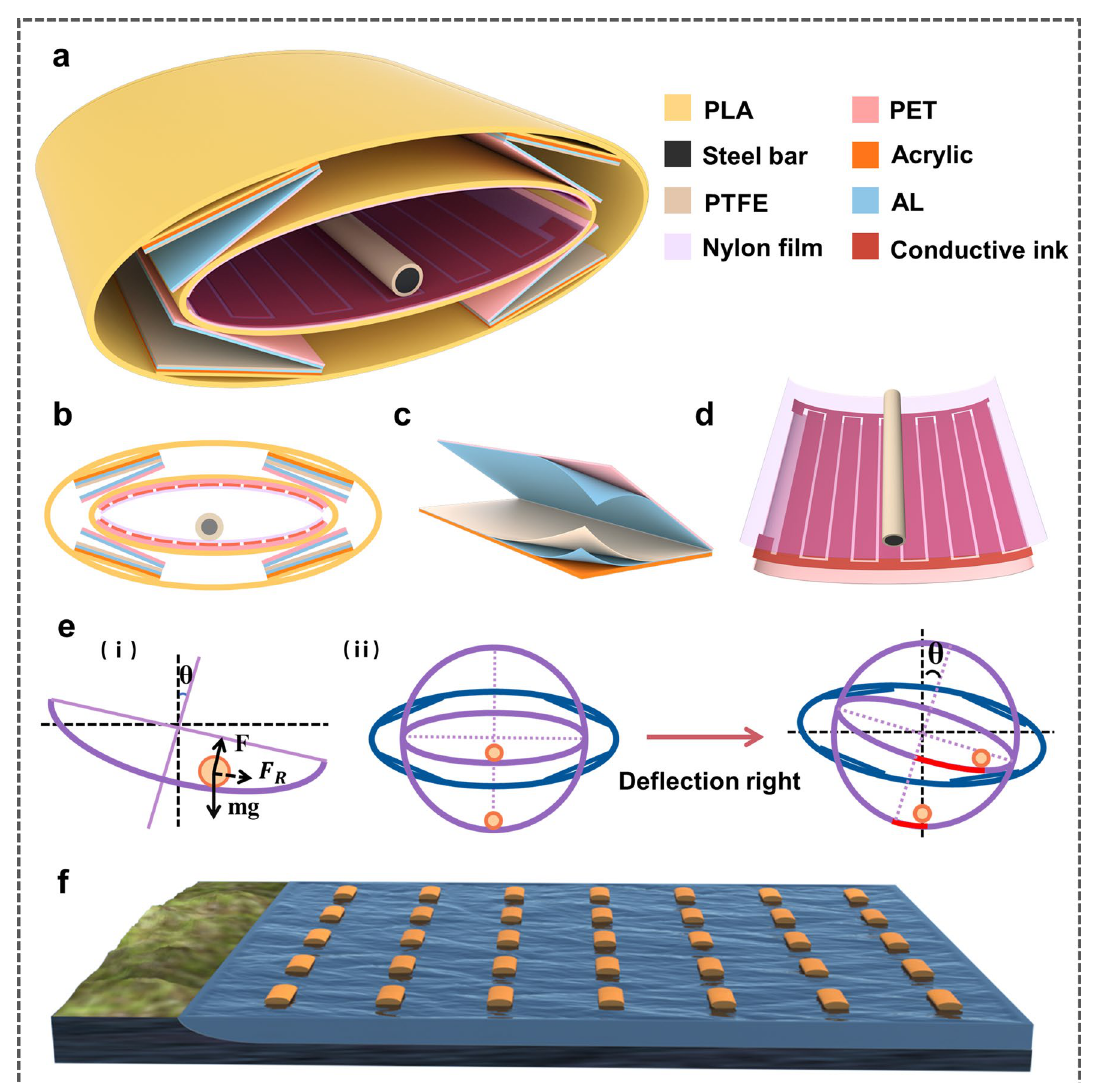
Fig. 1 Structure design of the EC-TENG. a Schematic diagram of the EC-TENG. b–d Schematic diagrams of the cross-sectional configuration of EC-TENG, outer V-shaped TENG, and inner TENG. e Dynamic analysis of a steel bar rolling in the inner shell (i), and comparison of the elliptic cylindrical shell with cylindrical or spherical shells in bar rolling distance under the same slant angle (ii). f Proposed network composed of the EC-TENGs for large-scale blue energy